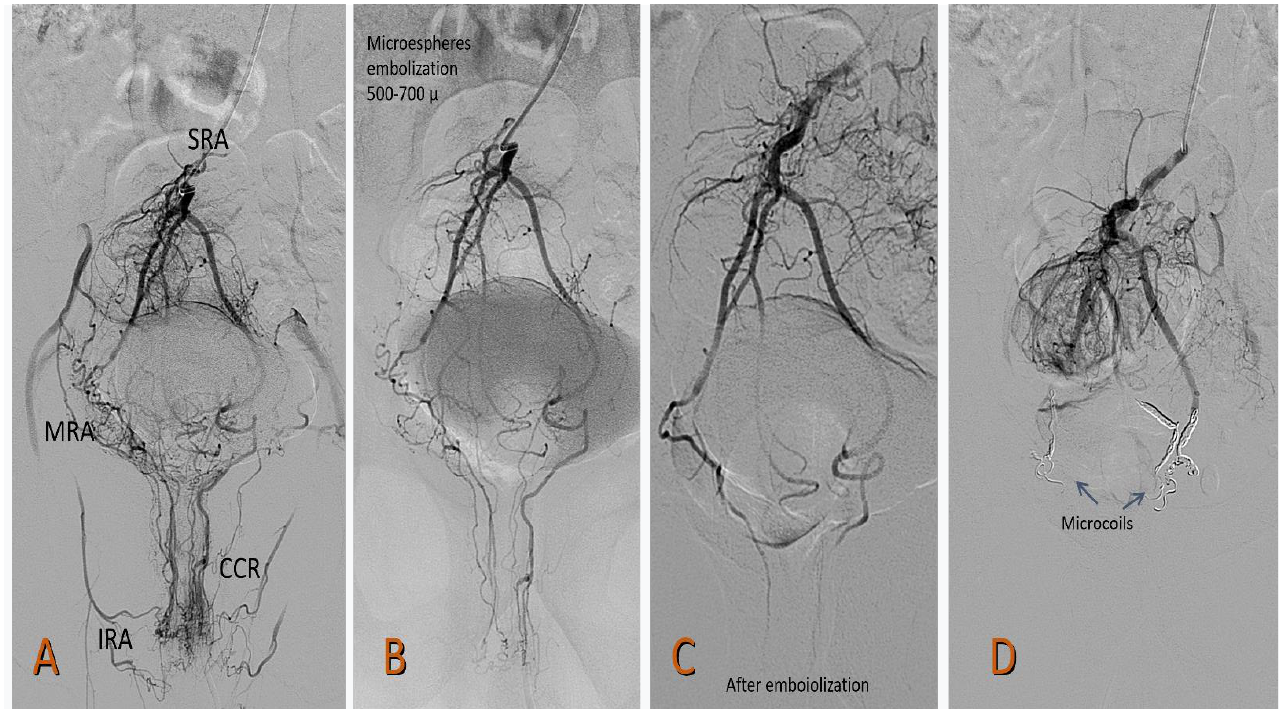
Figure 2. A 49-year-old patient with grade II HD (Goligher) and French bleeding score (FBS) of 6: ( A ) Selective arteriography from the inferior mesenteric artery in which asymmetry of both superior rectal arteries is observed. The right SRA is highly developed with communication with the MRA and IRA. Both provide a lot of risk to the CCR. The left SRA is poorly developed. ( B ) Embolization with 500–700 µ microspheres (Merit Medical). ( C ). Acceptable result after embolization. ( D ) Distal embolization with Prestige microspheres (Balt medical). SRA: superior rectal artery, MRA: middle rectal artery, IRA: inferior rectal artery, CCR: corpus cavernosum